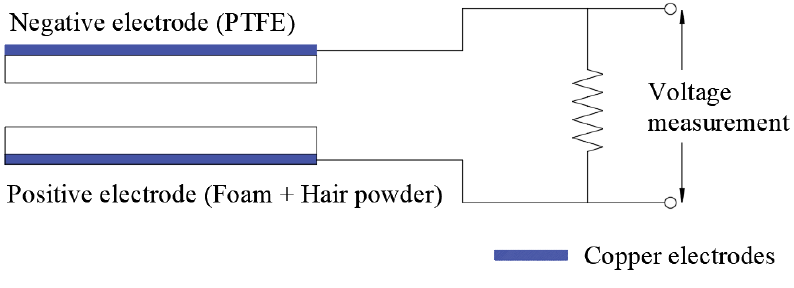
Figure 9. Arrangement for utilization of the electric energy in TENG.